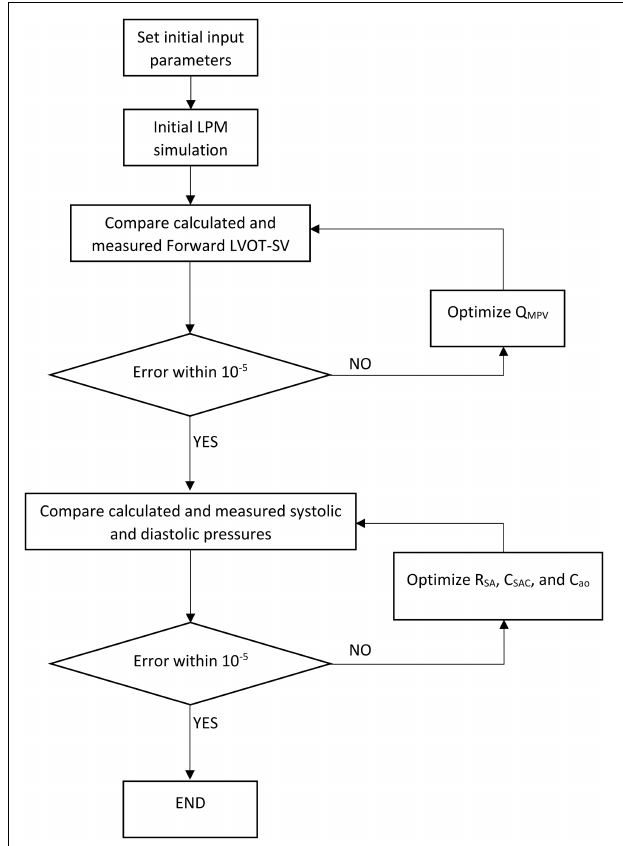
FIGURE 2 | Patient-specific response optimization flow chart. This flow chart was used for both C3VI-DE and C3VI-CT.